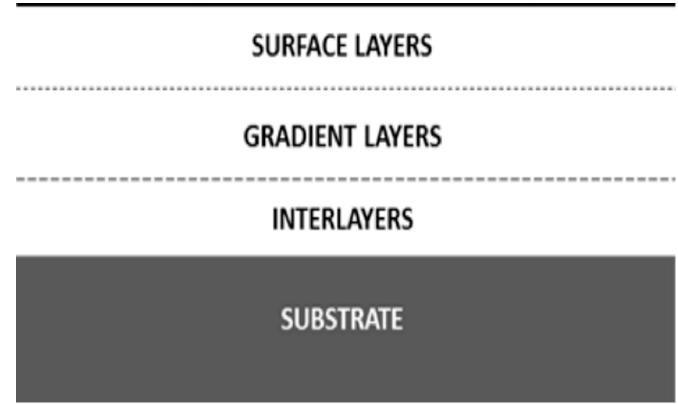
Figure 2. Schematic layout of the respective layers in a coating.